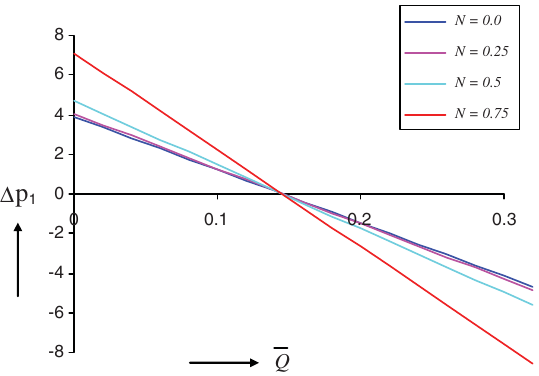
Fig. 8. Pressure difference across one wavelength vs. average flow rate based on Eq. (34) for N =0.0–1.0, φ =0.4 and M =1.0.